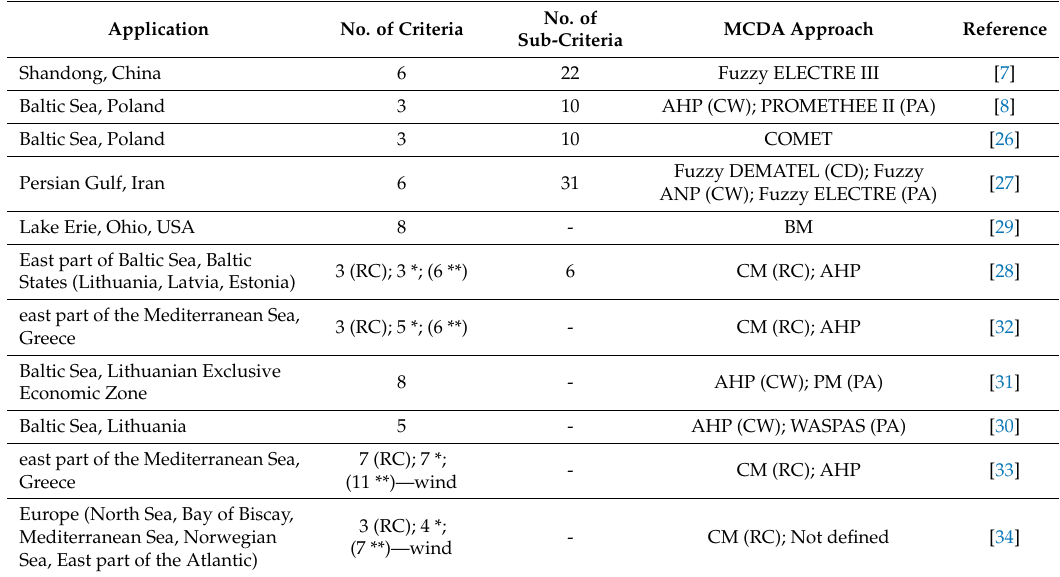
Table 1. Application of the MCDA (Multi-Criteria Decision Analysis) methods in the selection and evaluation of locations for offshore wind/hybrid